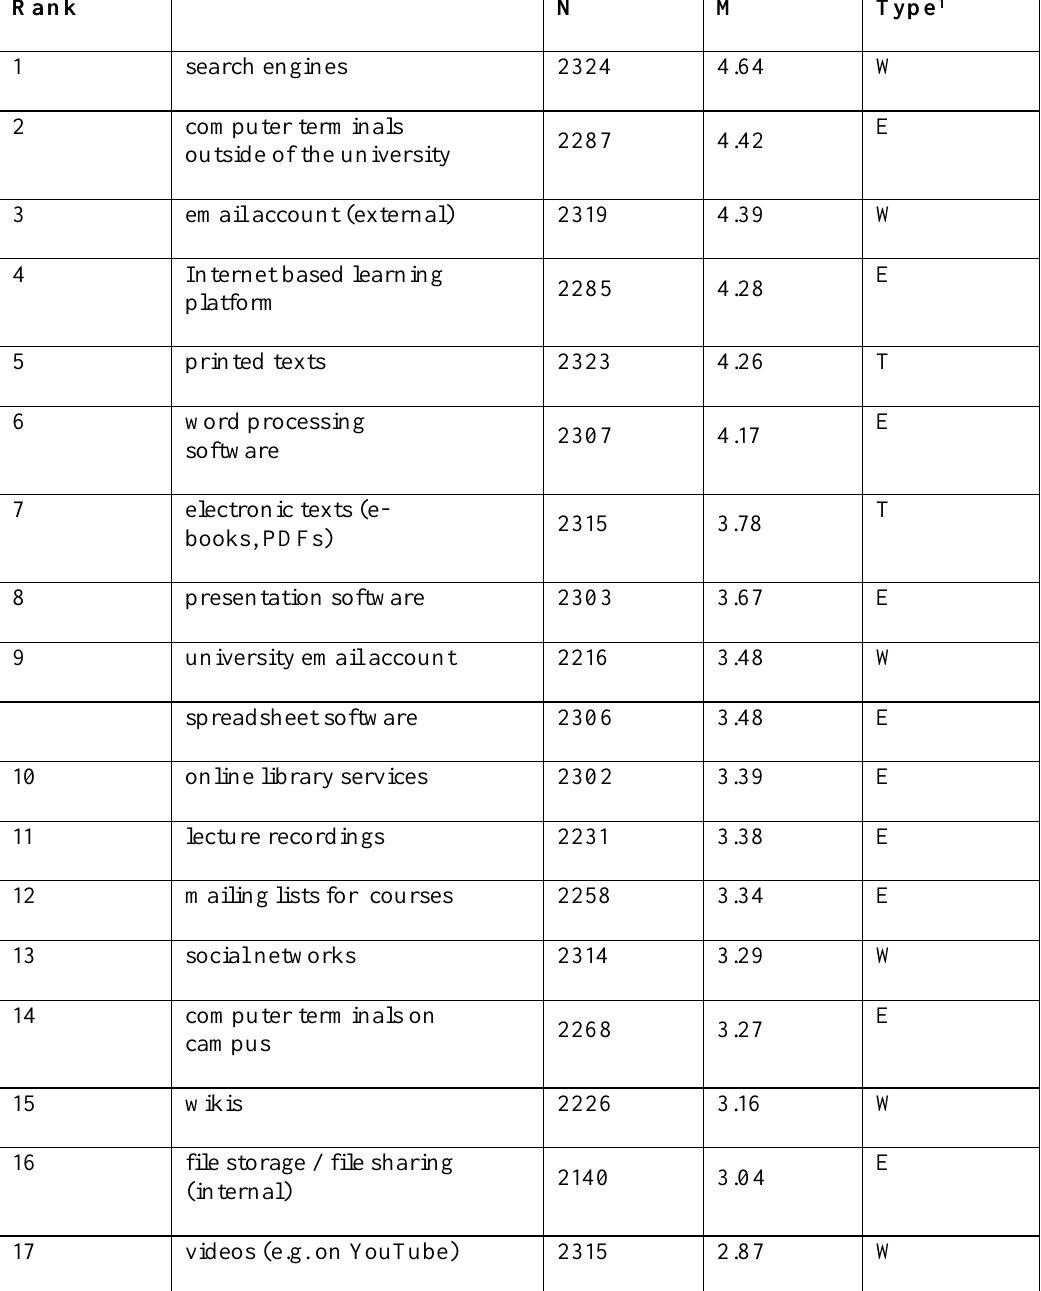
Ranking According to Acceptance of Media Tools and Services for Learning in Higher Education